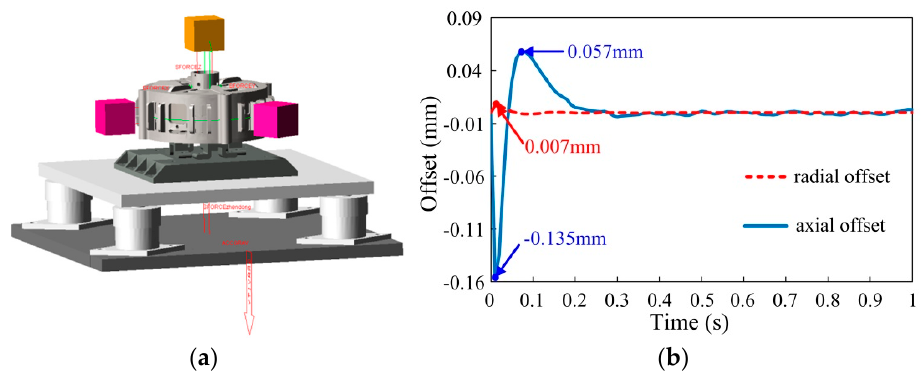
Figure 2. Vibration analysis under road condition. ( a ) A 3D model with ADAMS simulation software. ( b ) Contrast waveforms of radial and axial offsets affected by road conditions (B-level road roughness).